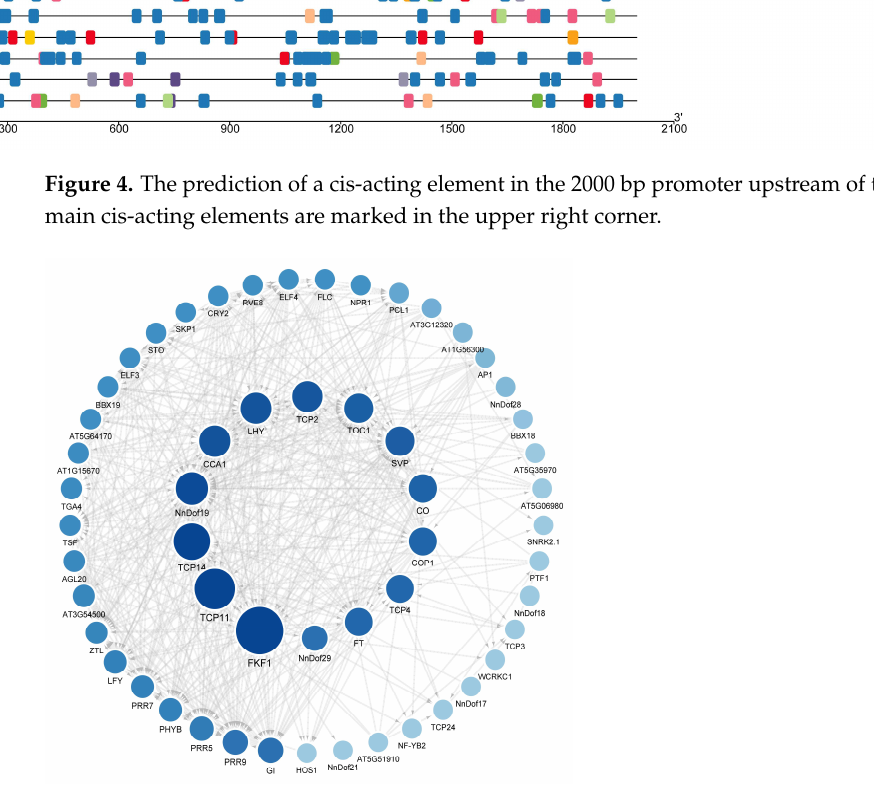
Figure 5. Protein interaction network of NnDofs protein with other Arabidopsis proteins predicted using the STRING-DB. The minimum required interaction score is a moderate confidence level of 0.400. Organism set: Arabidopsis. These lines reflect the interaction of Nndofs homologs with other proteins. The darkness of the circle color indicates the strength of the data